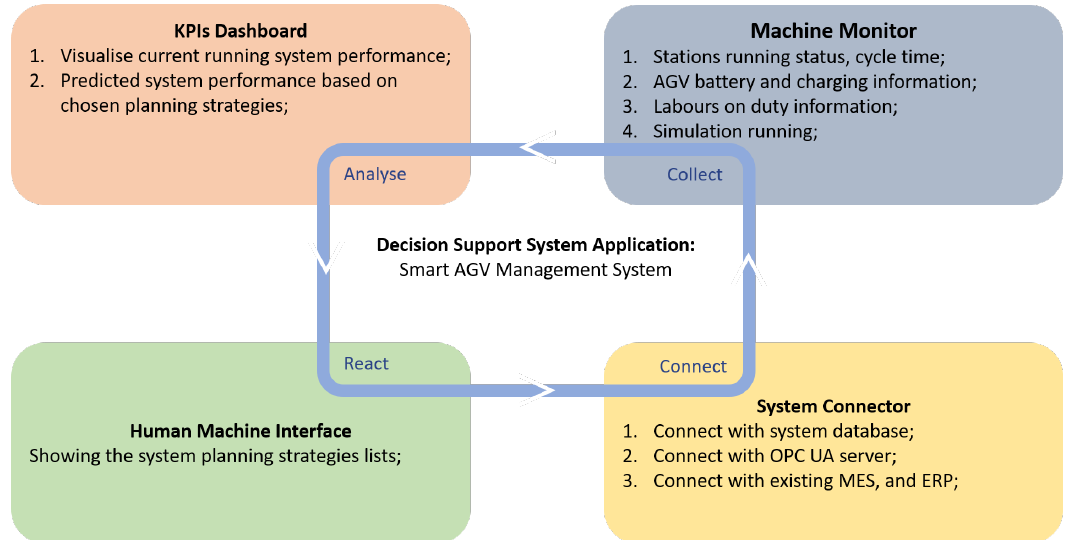
Figure 3. The main components of the decision support